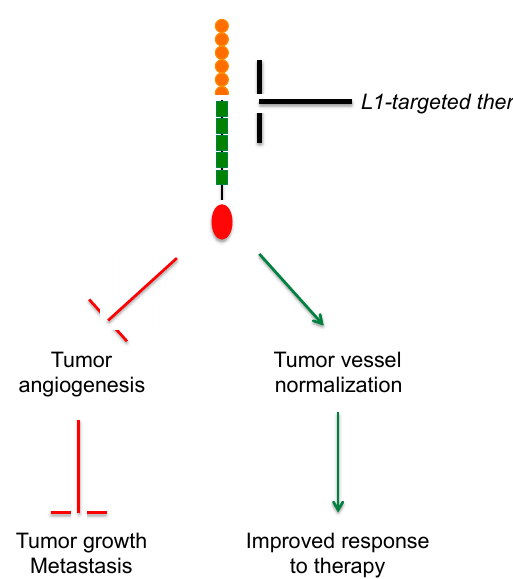
Figure 5. Outcome of L1CAM-targeted therapy in tumor vasculature. The inhibition of L1CAM function in tumor vessels (black T-shaped bar) is expected to result in decreased angiogenesis (top red T-shaped bar), thus leading to reduced tumor growth and metastasis (bottom red T-shaped bar), as well as to promote vascular normalization (top green arrow). The latter, in turn, would improve tumor perfusion and, therefore, delivery of systemically administered treatments, thereby enhancing the therapeutic response (bottom green arrow).